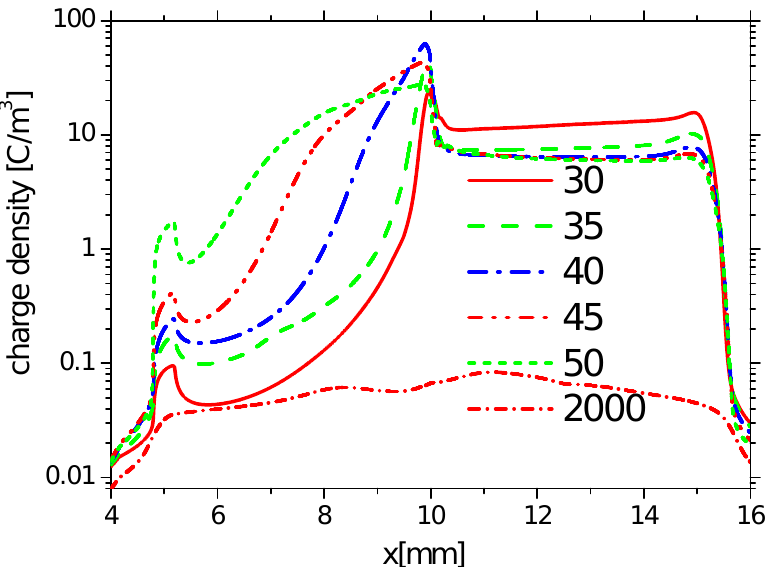
Figure 7. The distributions of charge density on the wall at time 30 ns, 35 ns, 40 ns, 45 ns, 50 ns, and 2000 ns in the fall phase in Case